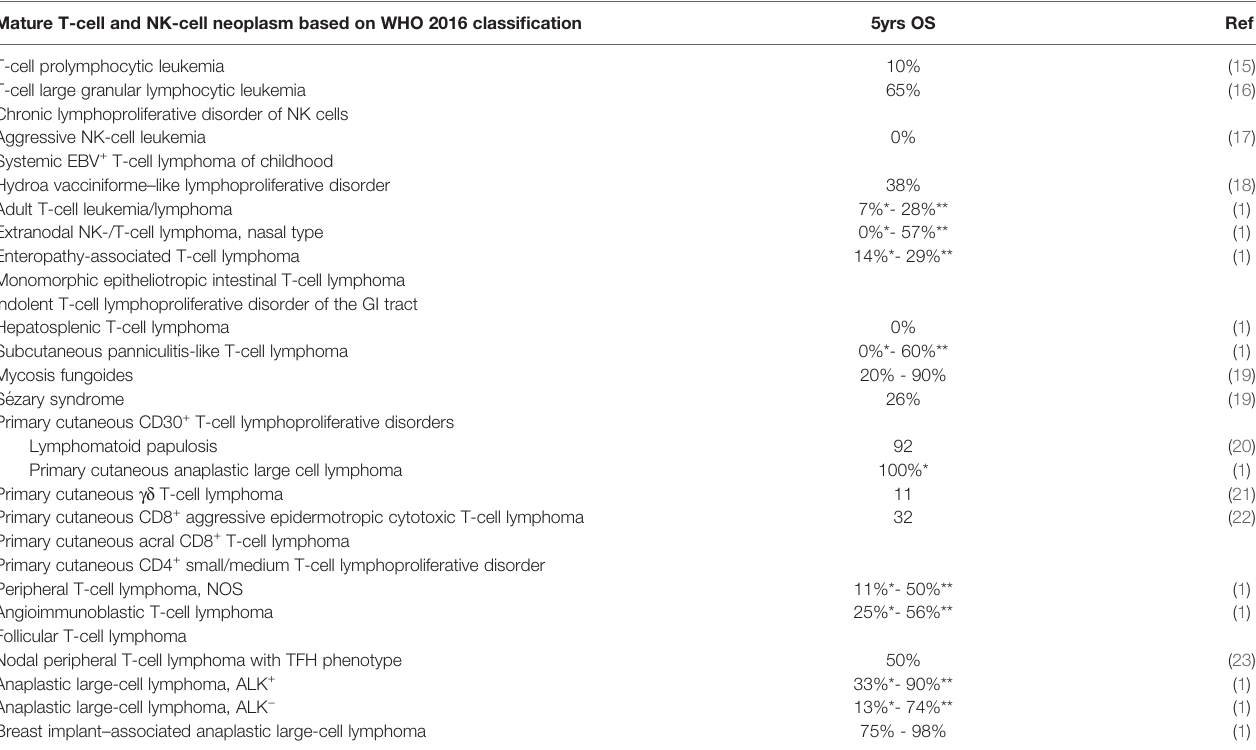
TABLE 1 | Outcomes of selected types of mature T-cell and NK-cell neoplasms (according to WHO 2016 classi fi cation). Mature T-cell and NK-cell neoplasm based on WHO 2016 classi fi cation